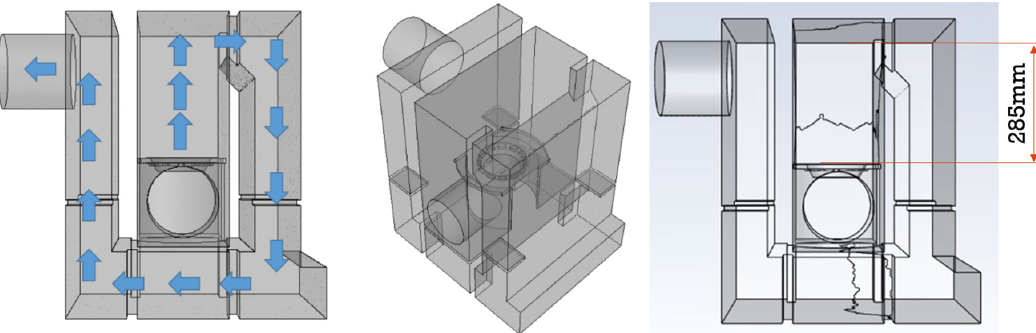
Figure 6. Geometry of furnace modelling.